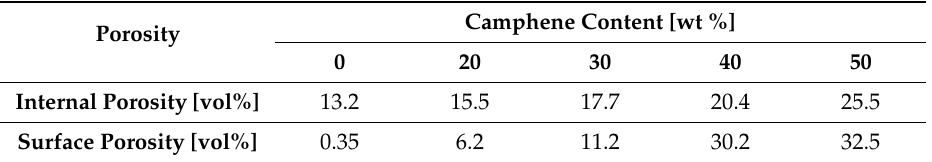
Table 2. Internal and surface microporosities of the PCL filaments produced using various camphene contents (0, 20, 30, 40, and 50 wt%).